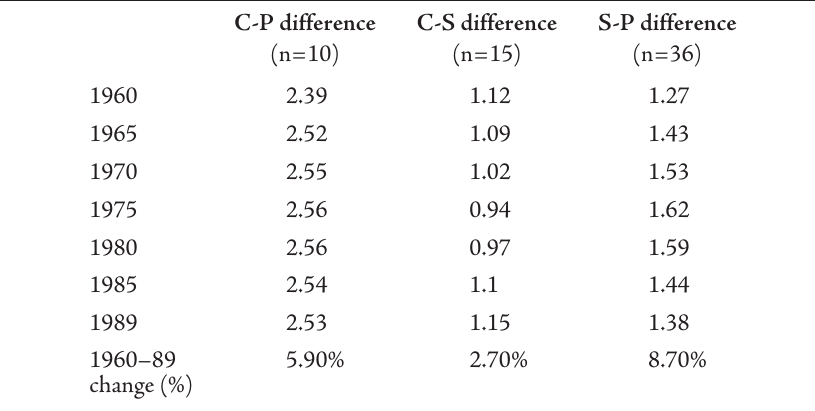
Table 7 – Inter-level differences in mean logged GDP per capita (PWT data; weighted results)